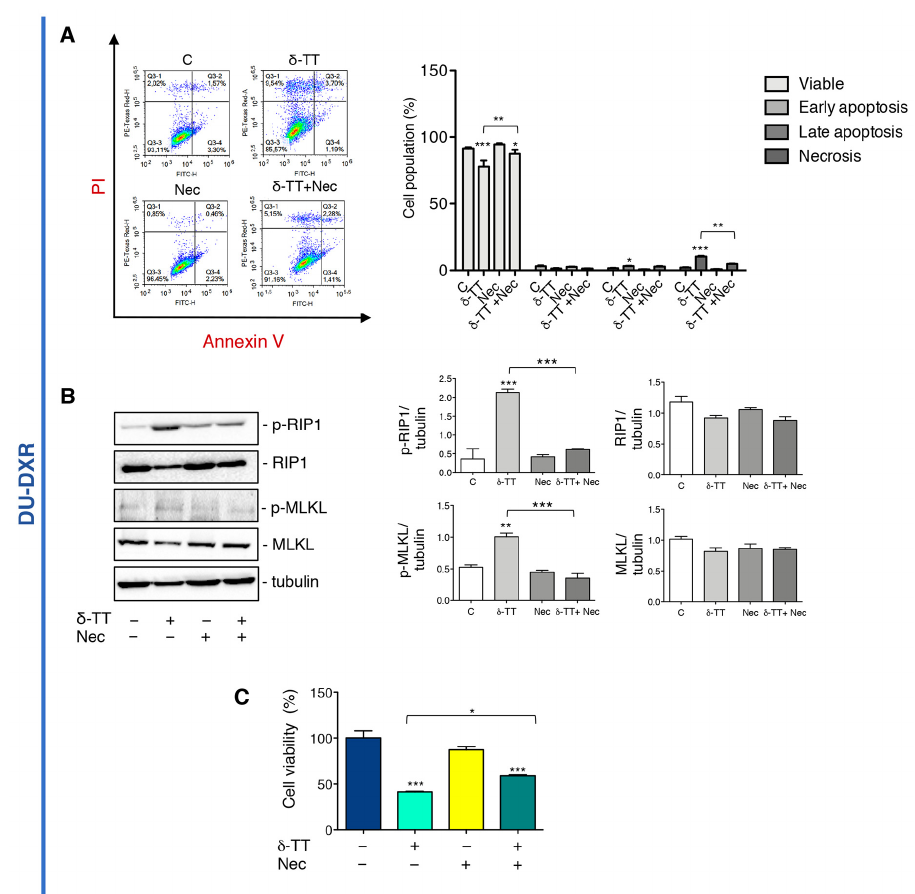
Figure 5. δ -TT induced necroptosis in DU-DXR prostate cancer cells. ( A ) Flow cytometric analysis by Annexin-FITC/PI double staining was performed after δ -TT treatment (20 µ g/mL, 48 h) in combination with Nec (50 µ M) in DU-DXR cells. Three independent biological samples for each condition were analyzed ( n = 3); bar graph represents the mean ± SD. Statistical analysis was performed using one-way ANOVA followed by Bonferroni post-hoc test (* p < 0.05; ** p < 0.01; *** p < 0.001). ( B ) The effect of δ -TT (20 µ g/mL, 24 h) in presence of Nec (50 µ M) was evaluated on p-RIP1, RIP1, p-MLKL and MLKL expression in DU-DXR cells. Tubulin was used as loading control. Three independent experiments for each condition were analyzed; bar graph represents the Bonferroni post-hoc test (** p < 0.01; *** p < 0.001). ( C ) Cell viability analysis after δ -TT